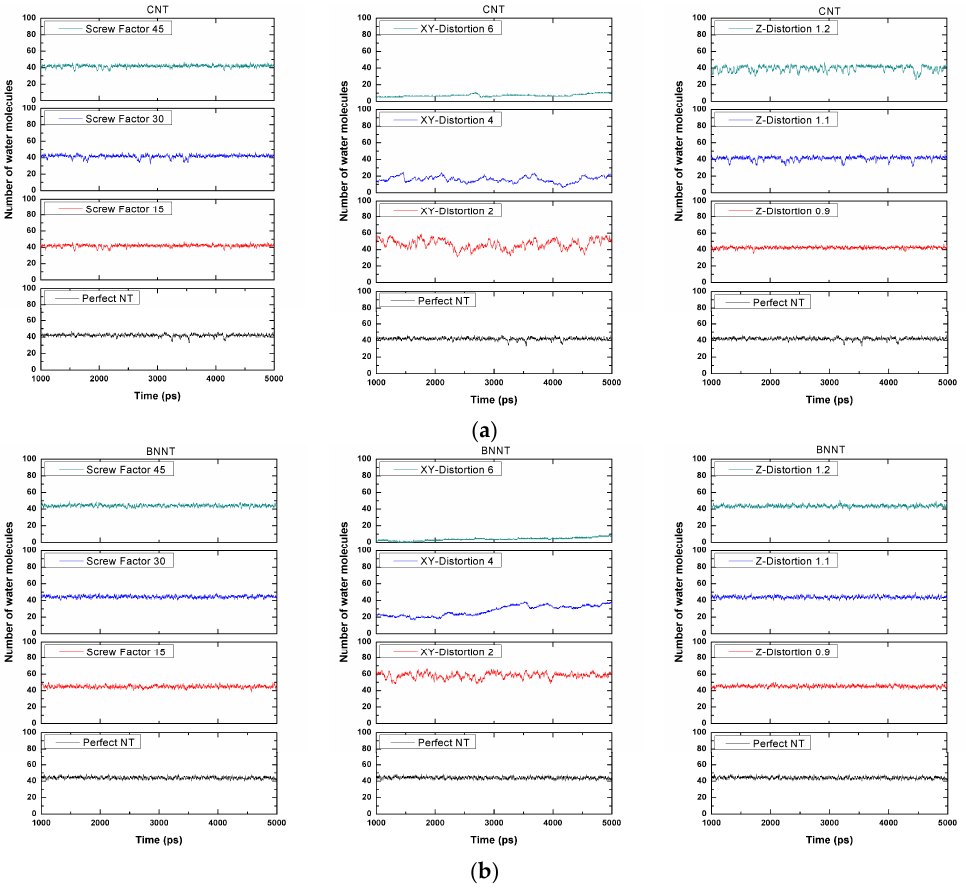
Figure 5. Water occupancy inside perfect and XY-distorted nanotubes versus time in picosecond: ( a ) carbon nanotube (CNT) and ( b ) boron nitride nanotube (BNNT). ( a ) carbon nanotube (CNT) and ( b ) boron nitride nanotube